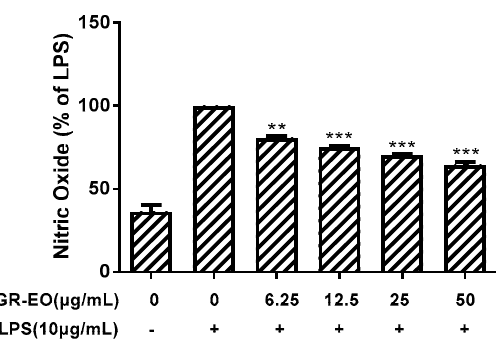
Figure 1. NO production with GR-EO in RAW 264.7 Cells. The cells were incubated with LPS (10 μ g/mL)